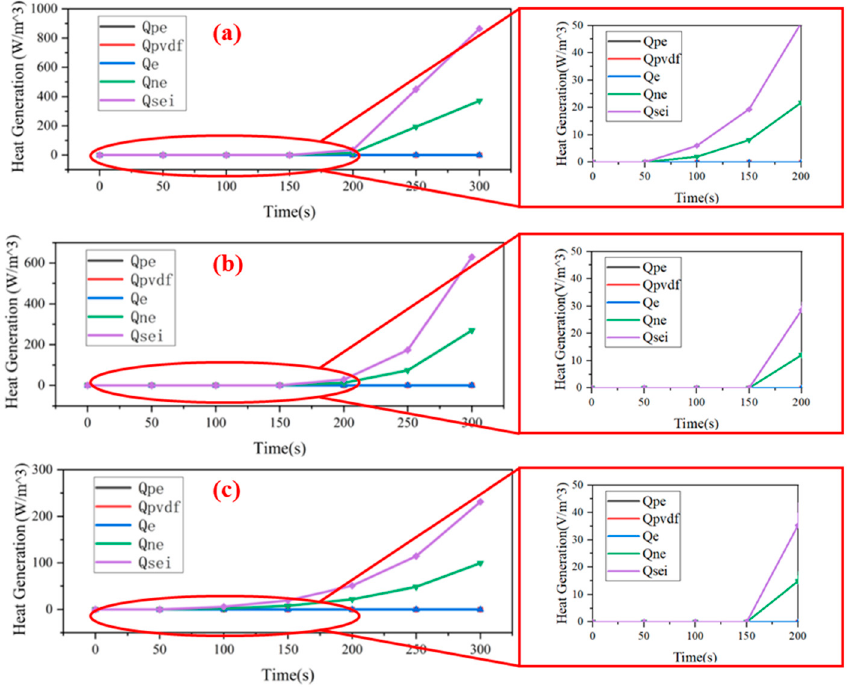
Figure 8. Heat production curves for the side reactions of each component: ( a ) 423.15 K; ( b ) 473.15 K; and ( c ) 523.15 K.